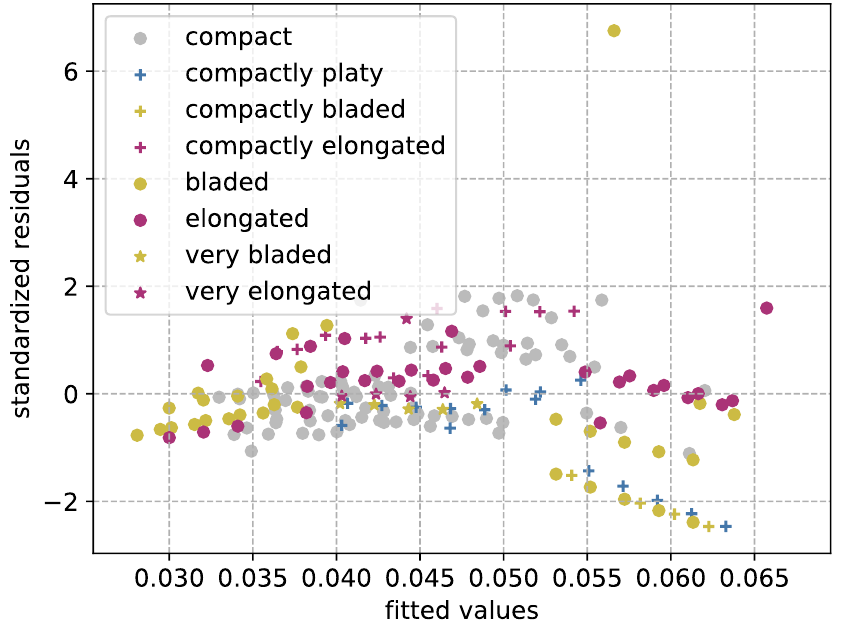
Figure 13. Tukey–Anscombe plot [70] showing the standardized residuals plotted against the fitted values, colored by shape classes according to Zingg